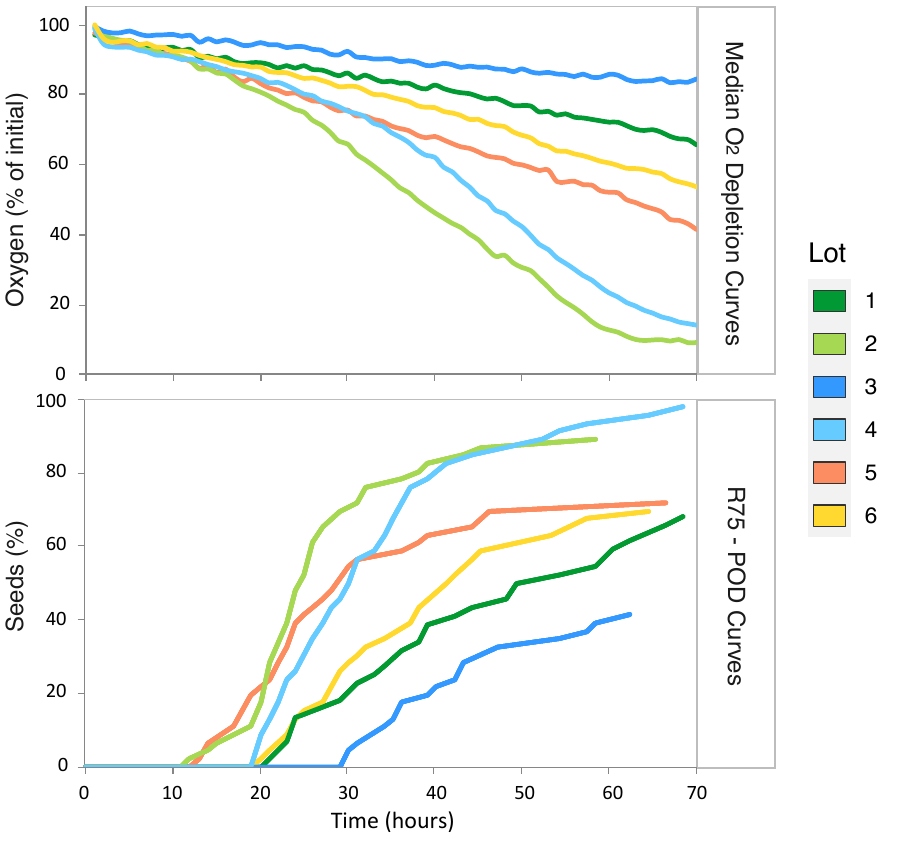
Figure 6. Median oxygen depletion curves (top) and R75 POD curves (bottom) of kohlrabi seed lots tested at 15 ◦ C for 72 h after blindness induction treatment at 1.5 ◦ C for 48 h. Seedling or tissue area measurements from the Videometer using nCDA models (Figure 8—top sections) after seed respiration measurements exhibited significant dif- ferences among seed lots. Seed lot 3 had the smallest exposed tissue area (median at 1602 pixels) with little to no seedling tissue visible in a large fraction of the seeds after the respiration measurements (Figure 8—see bottom panels for BLOB collection with seeds marked with dark blue circles compared to seed lot 4 of the same variety marked with light blue circles). Seed lot 5 displayed an intermediate median tissue area (2809 pixels), while lots 1, 2, 4 and 6 had higher median tissue areas at around 4200 pixels (Figure 9). The largest seedling size variation was present in seed lot 1, where a fraction of seeds showed little to no embryo tissue while another fraction displayed the largest seedlings in the study. This is consistent with the large variation among seeds in this lot for Q2-derived values (Figure